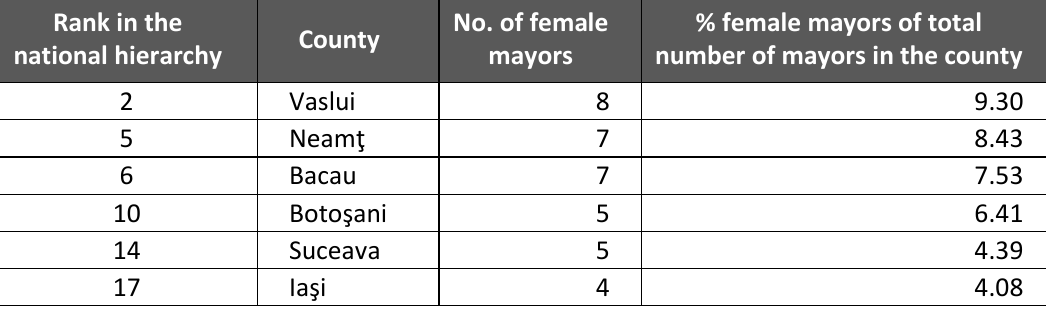
Table 2: The distribution of the female mayors in the North - Eastern Region at local elections in 2016 Rank in the national hierarchy